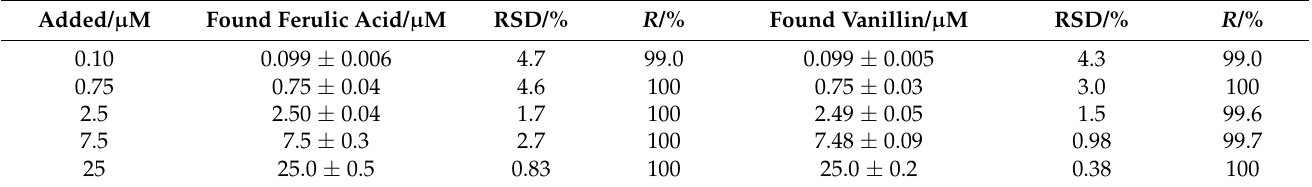
Table 4. Simultaneous determination of ferulic acid and vanillin in model mixtures ( n = 5; p =